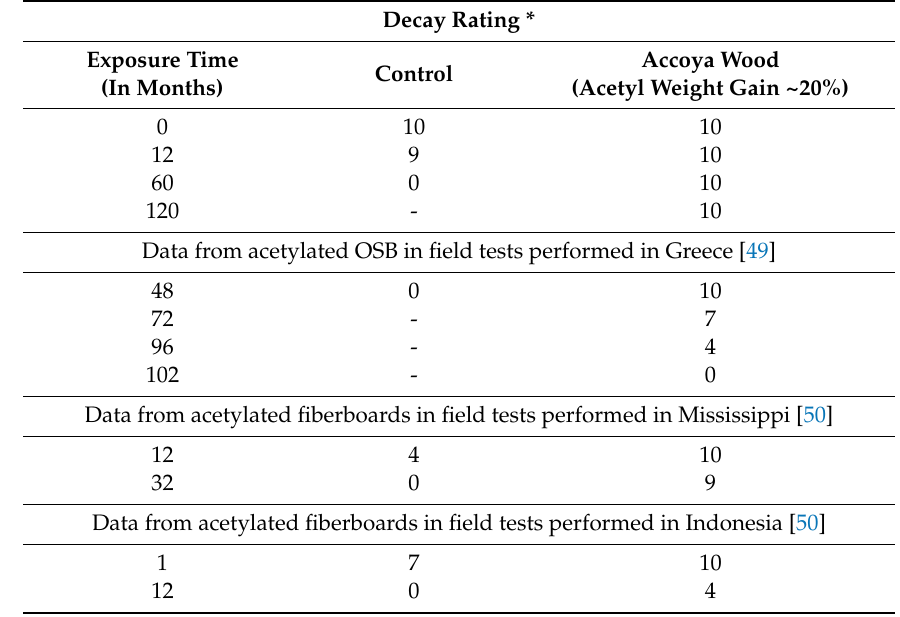
* A rating of 10 means no decay, 9 means slight decay, 7 means moderate decay, 4 means severe decay, and 0 means total decay. Mean values of 10 replicates. Table 2. Mechanical properties of Accoya wood in ground stake test in Greece. Table 2. Mechanical properties of Accoya wood in ground stake test in Greece.